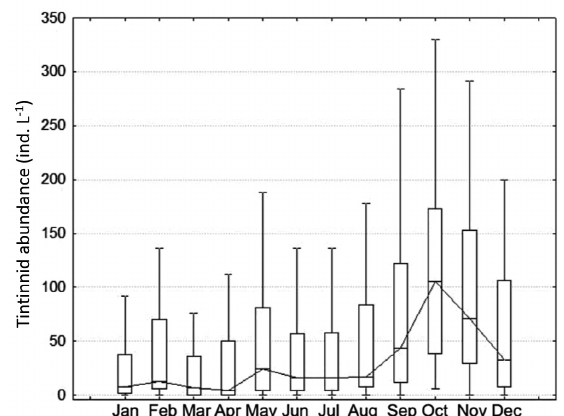
Figure 3. Box plots of monthly averaged abundance of tintinnids (ind. L -1 ) integrated within the 0–15 m water column. The black lines represent the median, the white rectangles represent the dispersion of the data (25–75%), and the black bars show the non-outlier range.